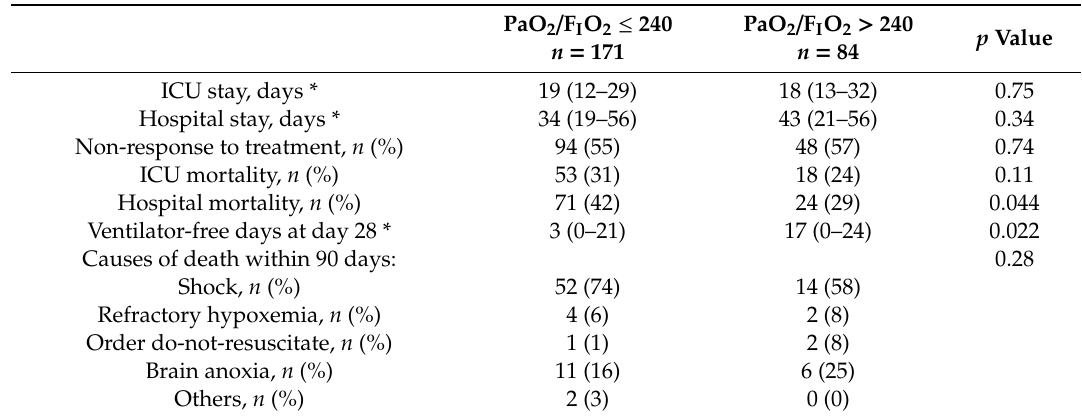
Table 5. Outcome variables.